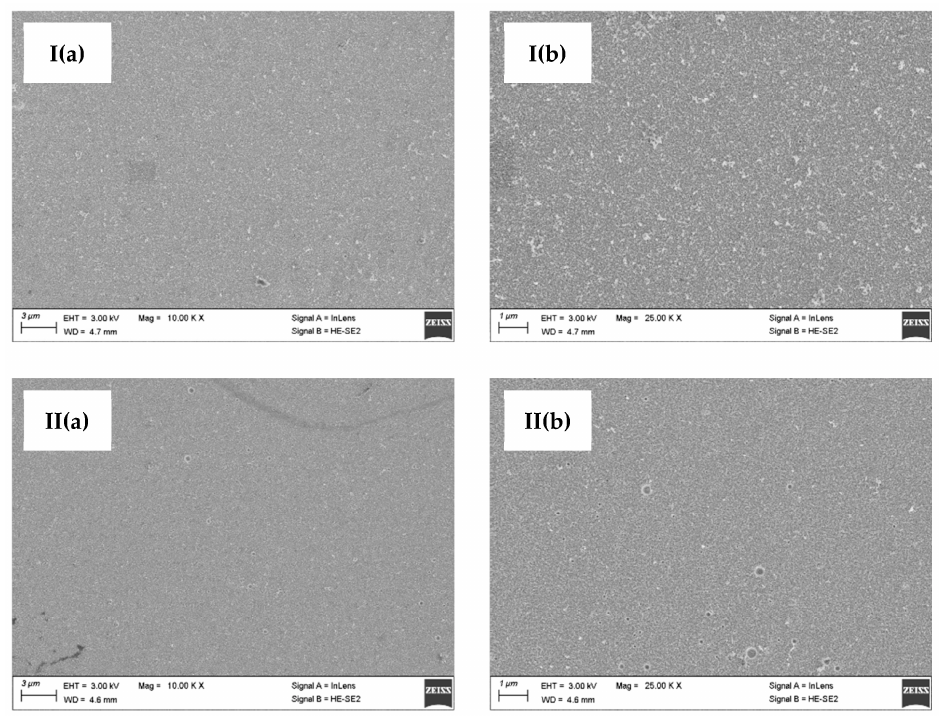
Figure 6. Surface morphology showed in SEM images (( a )—magni fi cation ×10,000, ( b )—magni fi ca- tion ×25,000) of zinc coatings obtained from ( I ) the RO retentate-based bath and ( II ) tap water-based bath. Table 6. Results of measurements of roughness parameters Ra and Rz of zinc coatings obtained from two types of baths.